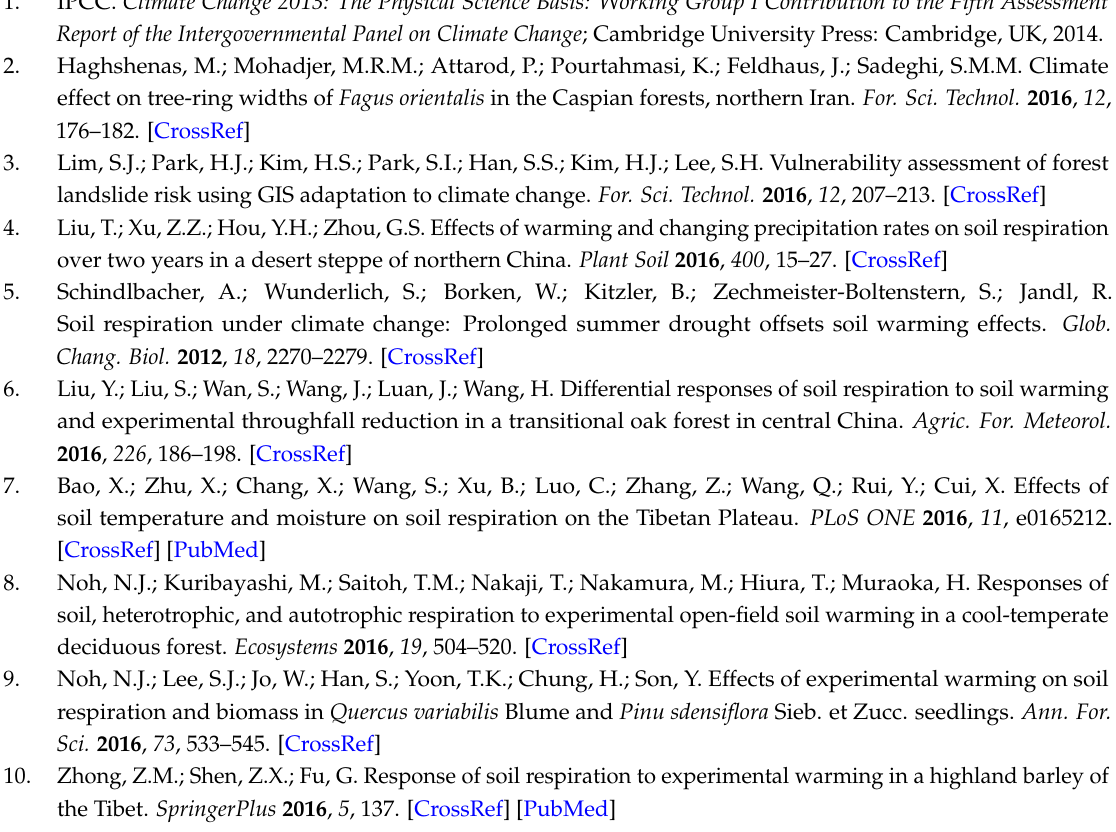
Repeated measures